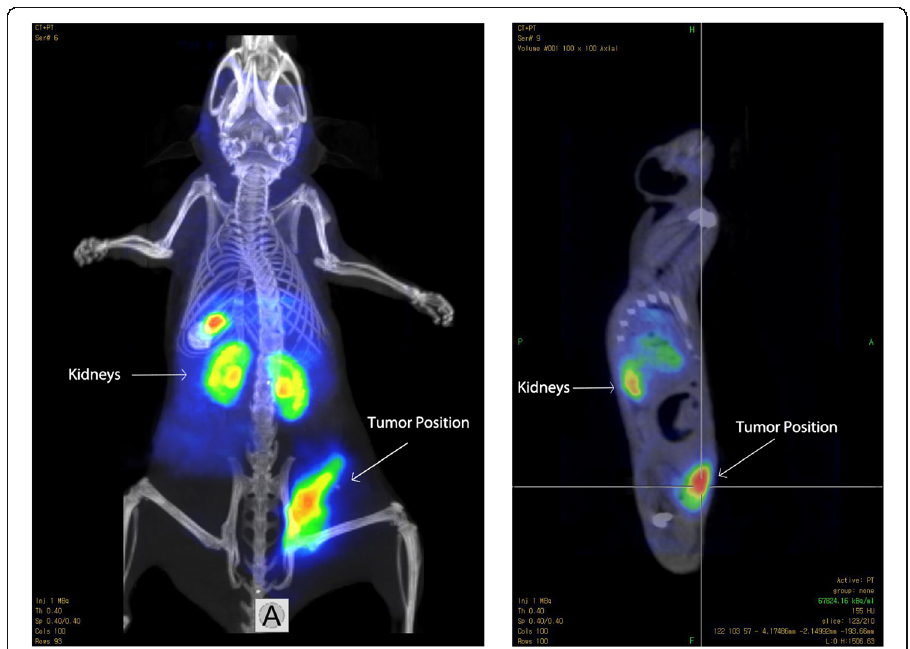
Fig. 5 Coronal and sagittal images of tumor-bearing mouse after 1 h Post-injection using 5 MBq